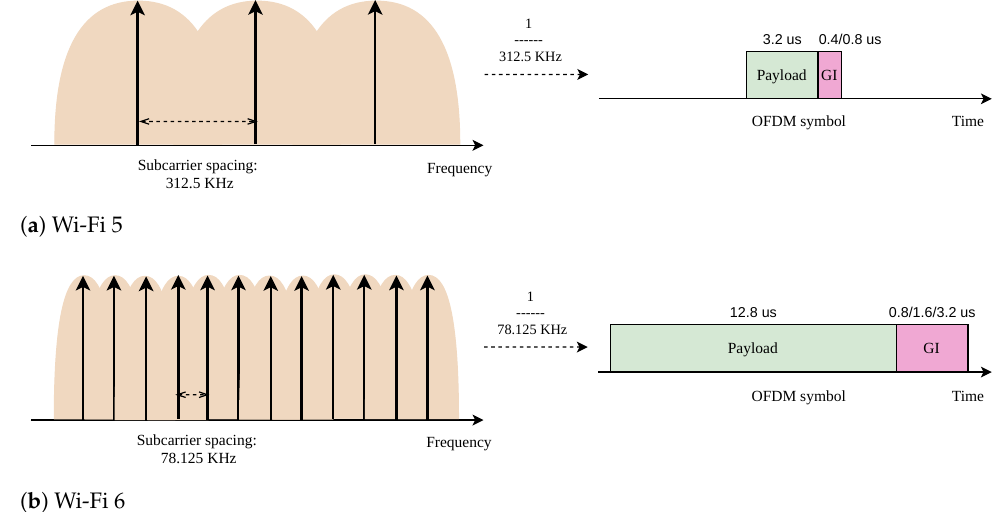
Figure 3. Wi-Fi 5 and Wi-Fi 6 comparison in terms of subcarrier spacing and OFDM symbol duration. Payload symbol duration is reciprocal to subcarrier